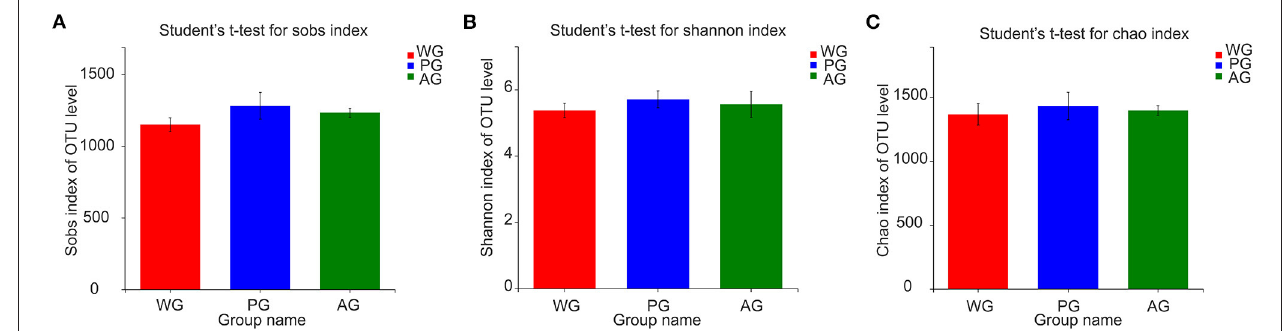
FIGURE 1 | Alpha diversity statistics comparison. (A) Sobs index of OTU level. (B) Shannon index of OTU level. (C) Chao index of OTU level. Steers were fed a wheat straw diet (WG), n = 4; Steers were fed a peanut vine diet (PG), n = 4; Steers were fed an alfalfa hay diet (AG), n = 4. Error bars represent standard deviations and their lengths are adjusted at 95% confidence interval.